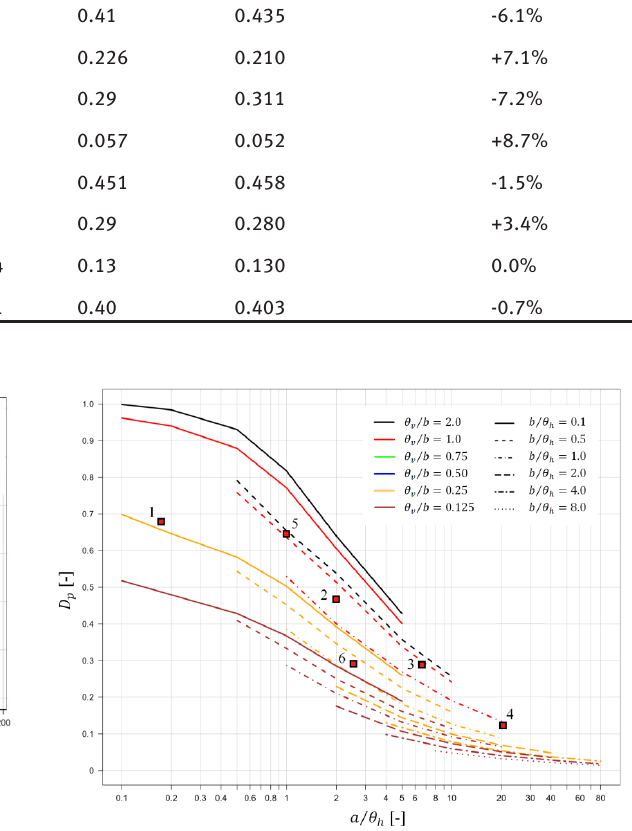
Figure 9: Illustration of example scenarios. Note that the colour in the legend indicates θ the legend) indicates θ